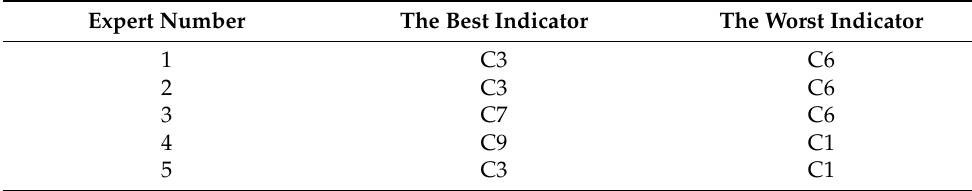
Table 1. The best and worst criteria determined by five invited experts.